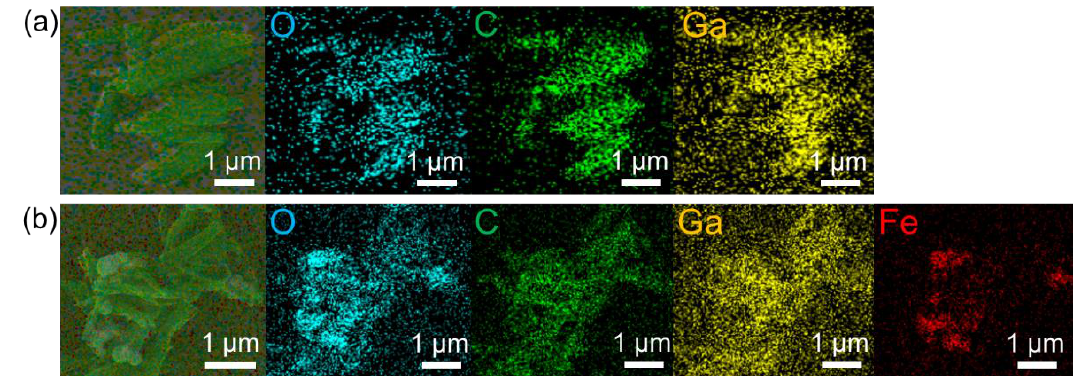
Figure 2. EDS mapping images of MIL-68(Ga) ( a ) and magnetic MIL-68(Ga) ( b ).